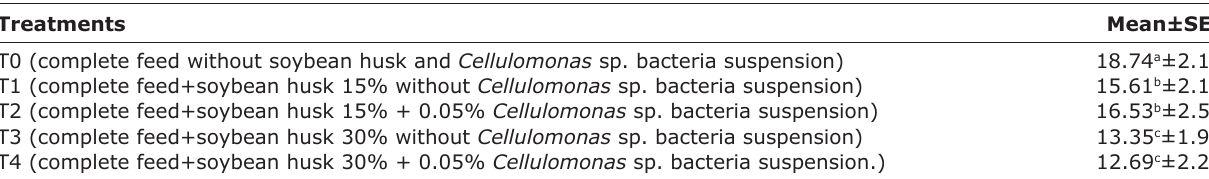
Table-3: Mean and standard deviation of egg yolk cholesterol levels of Anas javanica .